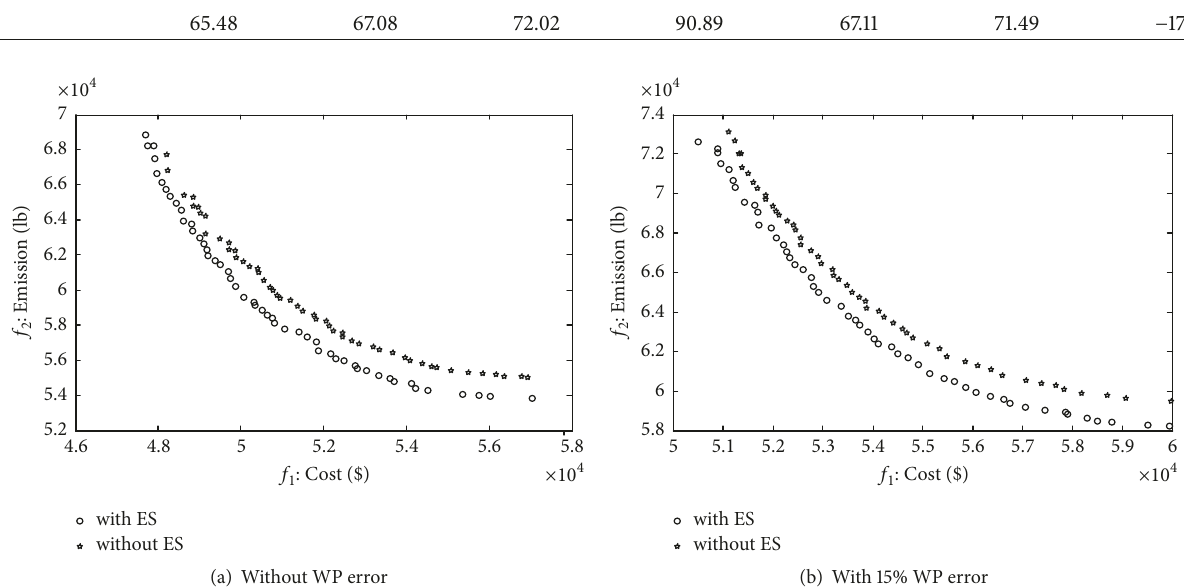
Figure 8: Pareto fronts obtained in scenarios with ES and without ES from the